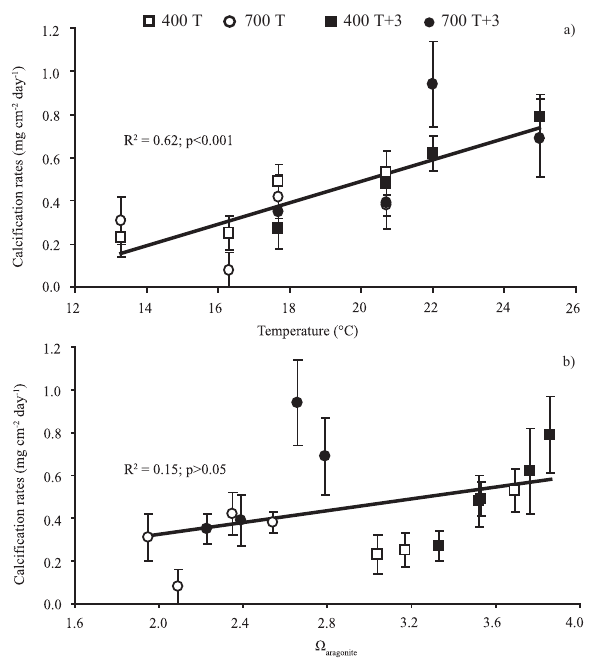
Fig. 5. Relationships between the mean calcification rates of Clado- cora caespitosa measured during the long-term experiment and: (a) temperature regimes (range 13.3–25 ◦ C); (b) (cid:127) aragonite . Open sqare 400 T ; closed square 400 T +3; open circle 700 T ; closed circle 700 T +3. The coefficient of the regression is reported as R 2 . Data are mean ± s.e.m. ( n =